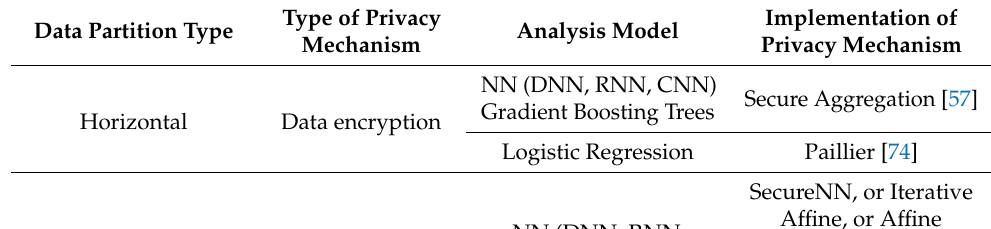
Table 3. Privacy mechanisms implemented in FATE 1.5.0.